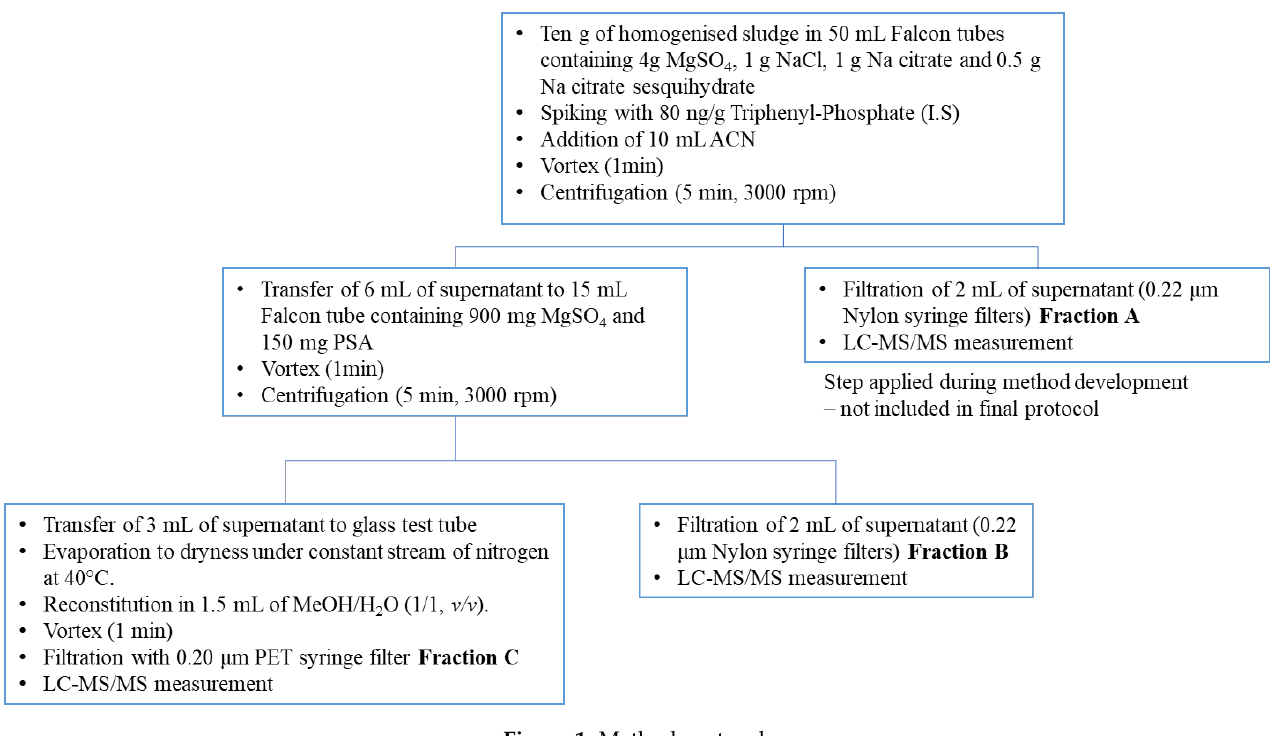
Figure 1. Method protocol.